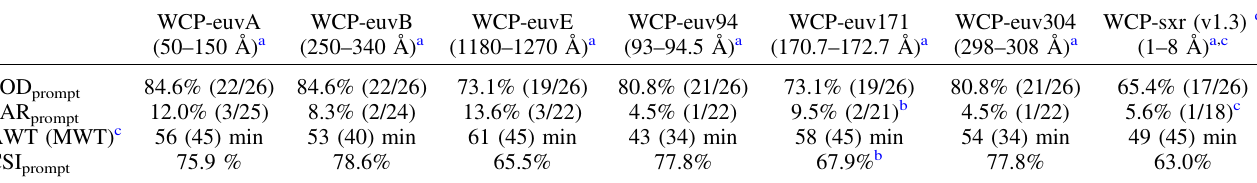
Table 3. This table summarizes the forecasting results of the WCP-euvA, WCP-euvB, WCP-euvE, WCP-euv94, WCP-euv171 and WCP- euv304 models using calibration data for predicting the events in Table 4 that took place from May 2010 to October 2014. This table also presents the forecasting results of the version 1.3 of the SXR-based WCP which was also calibrated with data up to October